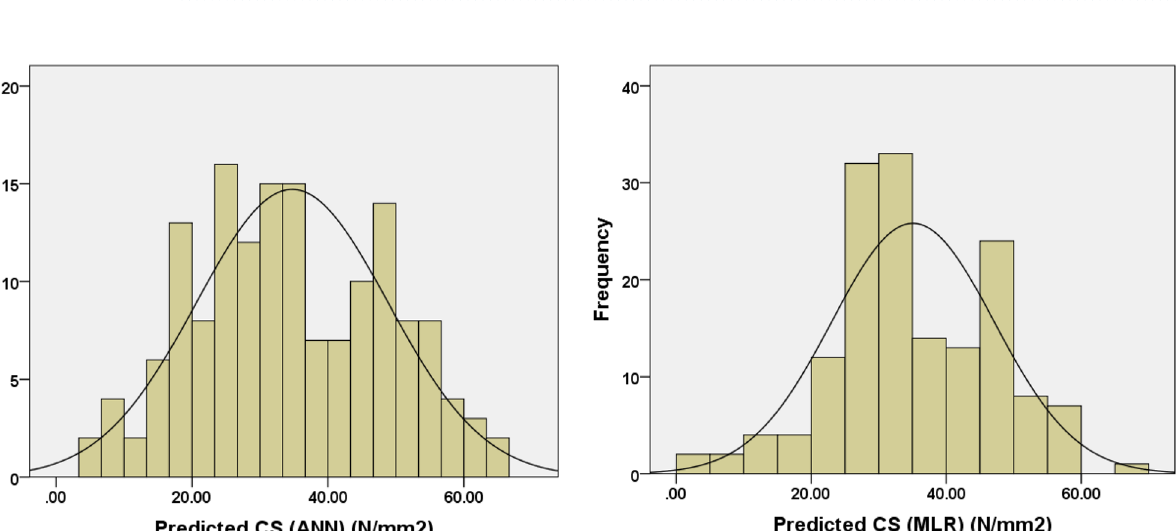
Table 3. Descriptive analysis of predicted compressive strength.